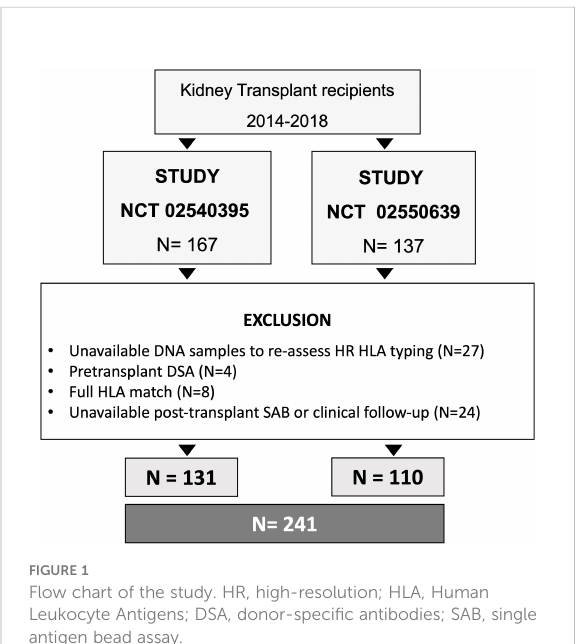
FIGURE 1 Flow chart of the study. HR, high-resolution; HLA, Human Leukocyte Antigens; DSA, donor-speci fi c antibodies; SAB, single antigen bead